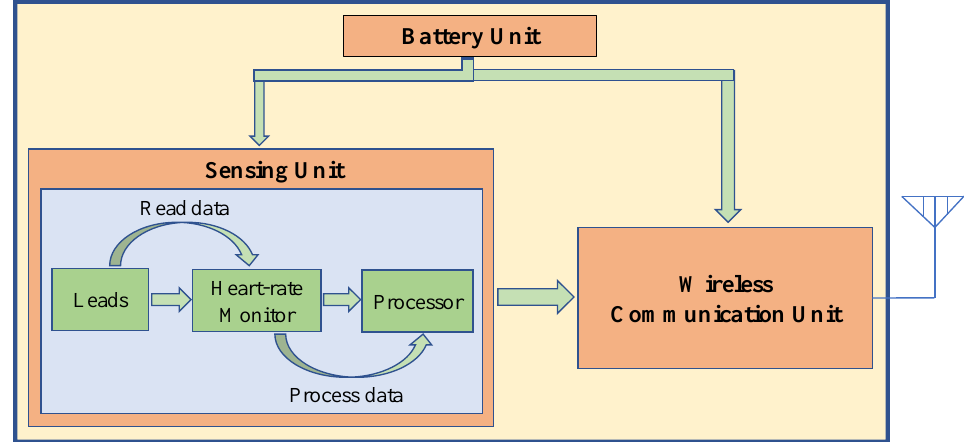
Figure 1. General hardware architecture of an electrocardiogram (ECG) sensing